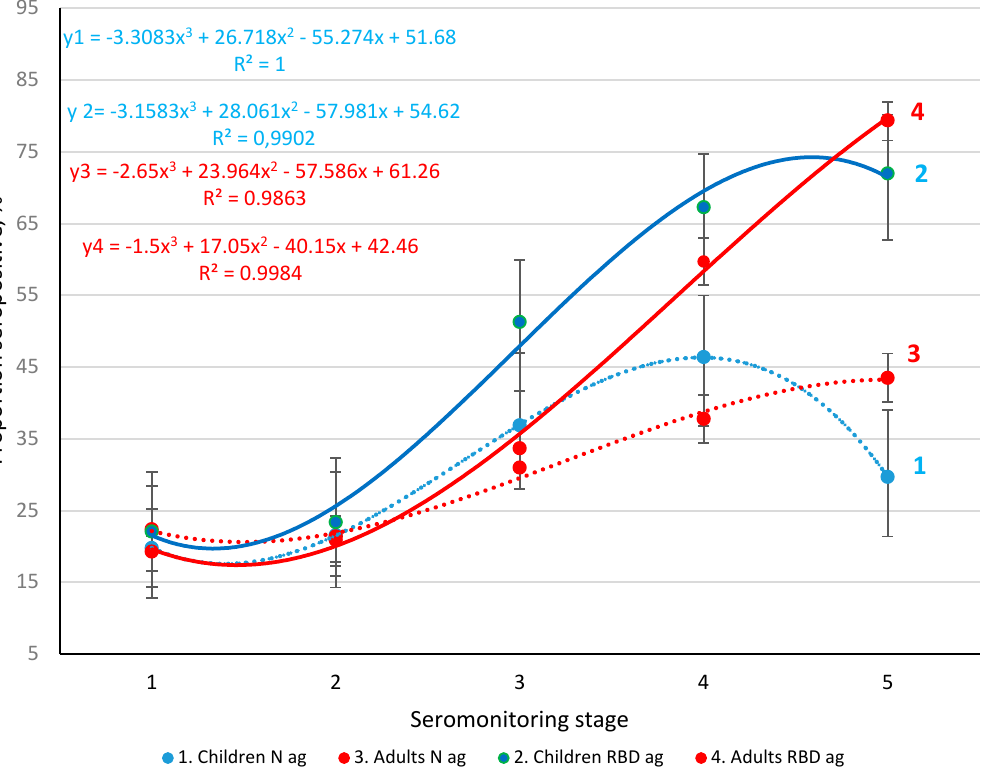
Figure 2. Distribution of seropositivity to N and RBD antigens (ag) in children and adults, by seromonitoring stage. Colored curves are trend lines for the percent seropositive among 1—children (N ag); 2—children (RBD ag); 3—adults (N ag); and 4—adults (RBD ag). Regression equations and coefficients of determination, in their corresponding colors, are shown in the upper left (y2, y4) and lower right (y1, y3) corners. Black vertical bars are the 95% confidence intervals. The summarized data are given in Table S1.